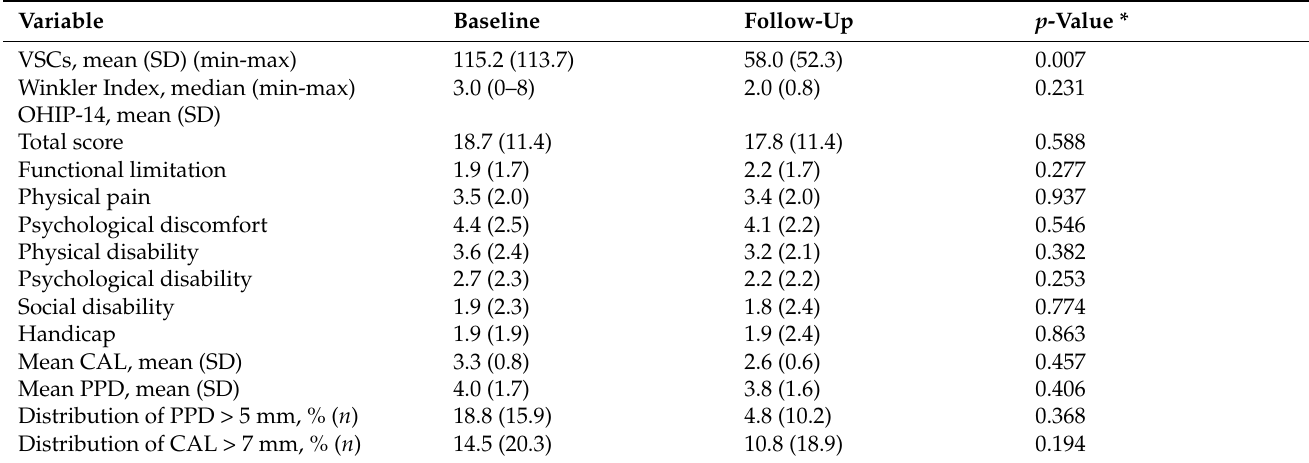
Table 2. Participants baseline and follow-up periodontal and halitosis measurements.